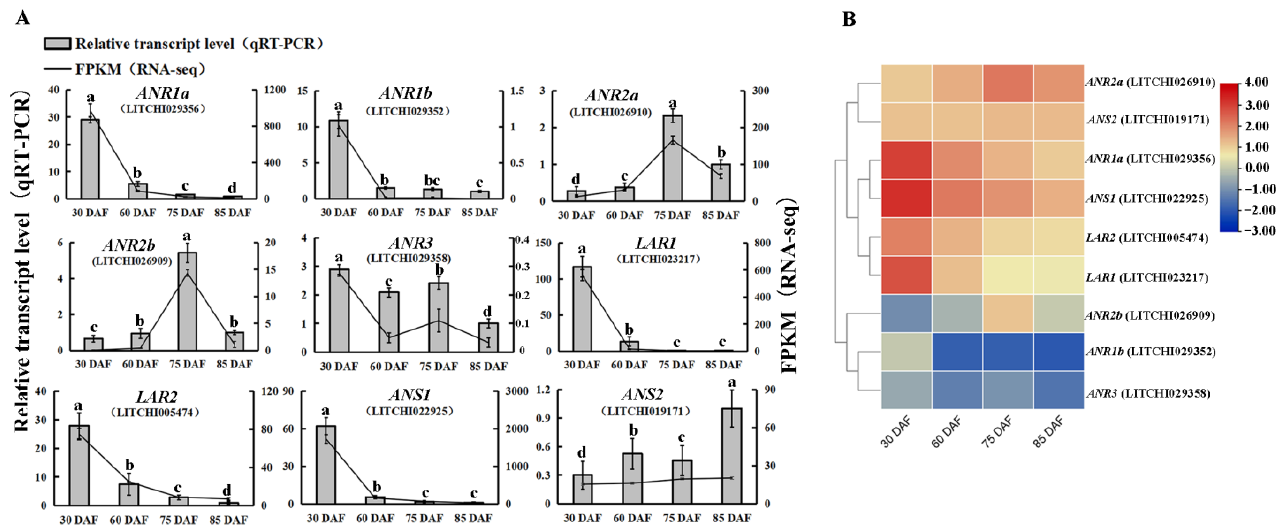
Figure 5. Verification and hierarchical clustering of the expression of PA biosynthesis-related